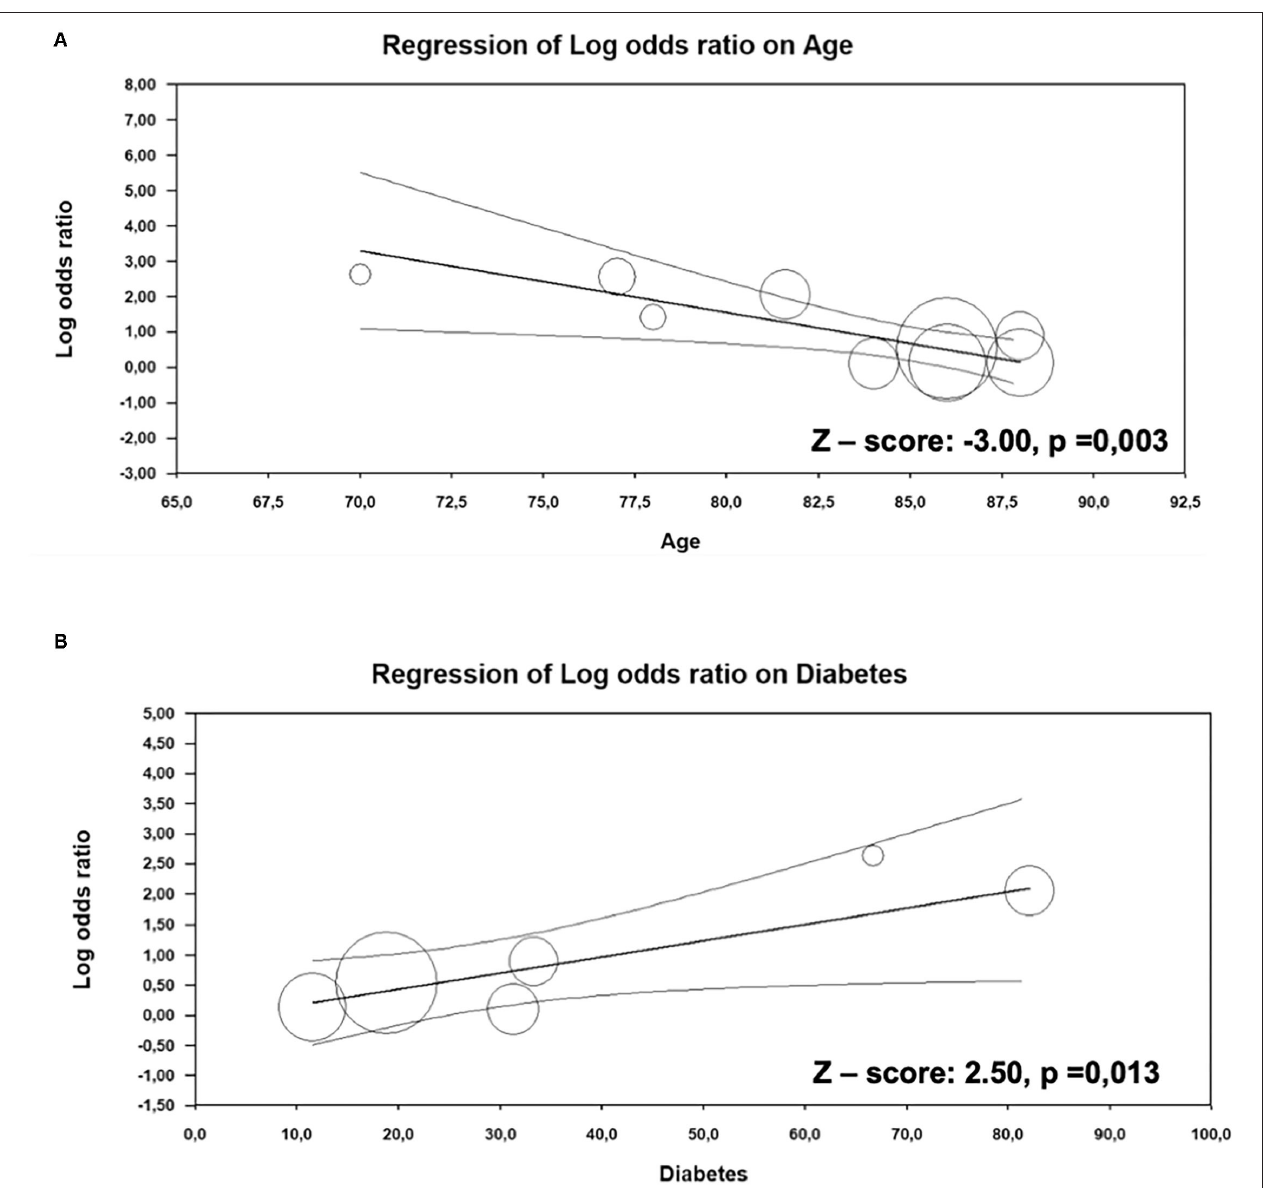
FIGURE 4 | Meta-regression analysis. Impact of age (A) and diabetes (B) on the difference in overall mortality between AS patients with and without